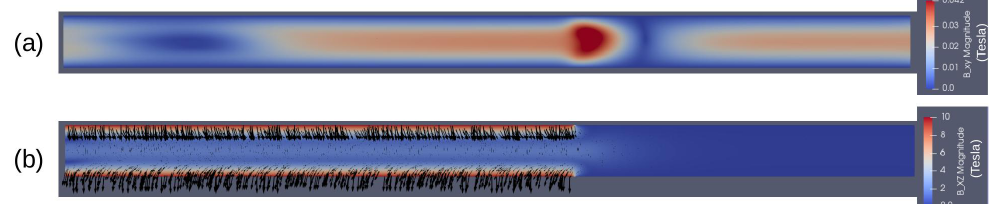
Figure 9. Distribution of magnetic induction in the ( a ) x-y plane and ( b ) x-z plane. Magnets are in the attractive